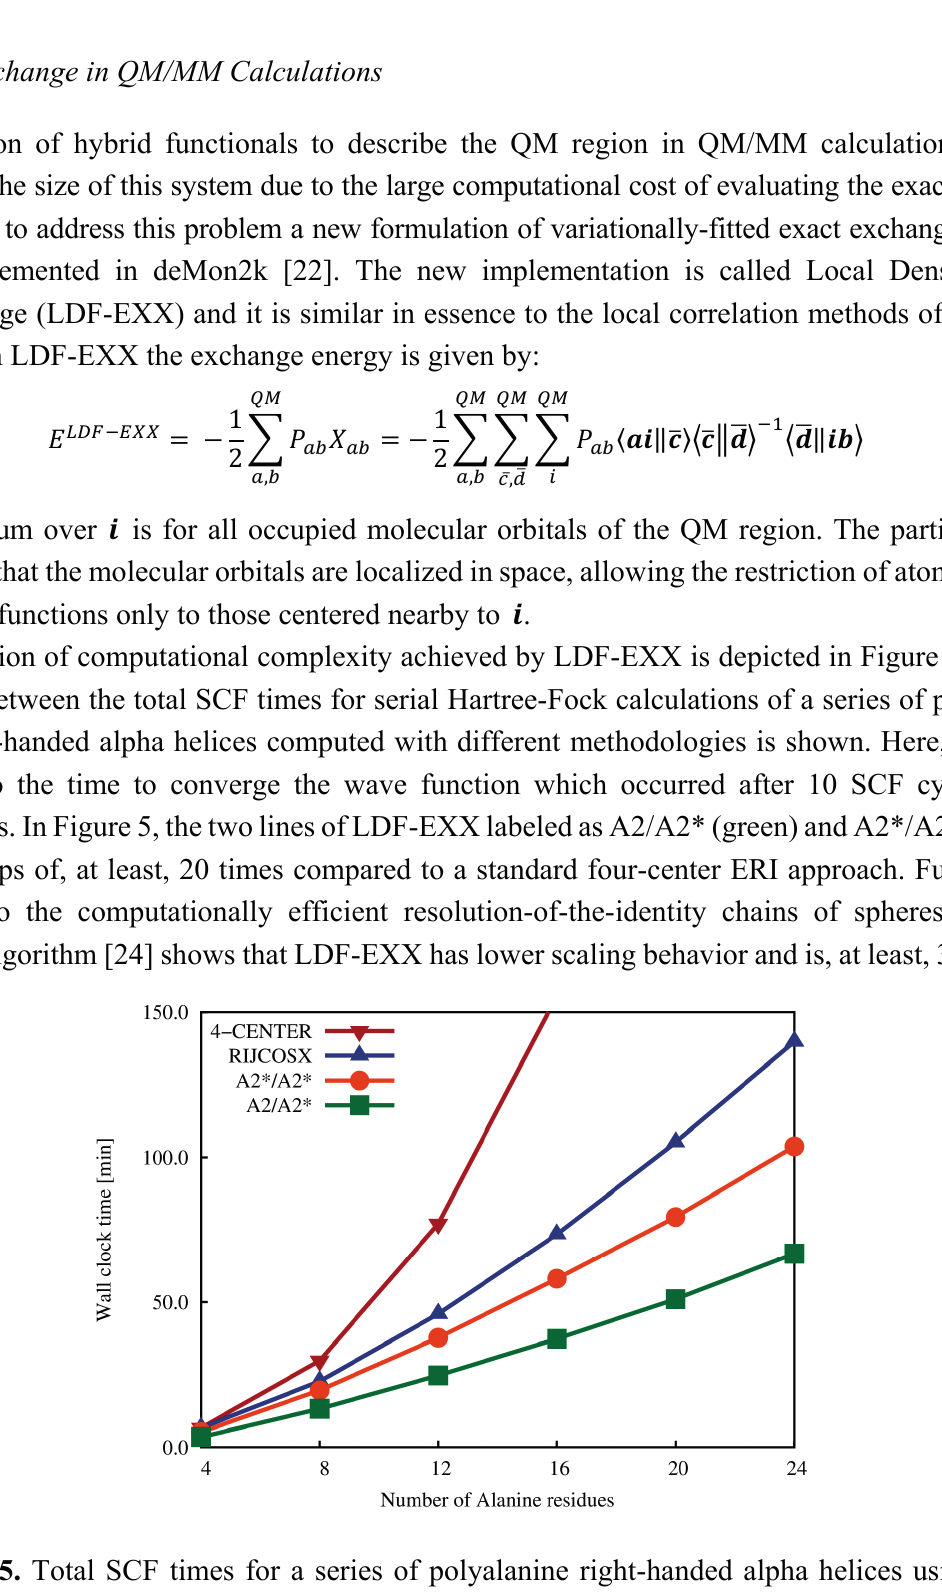
Figure 5. Total SCF times for a series of polyalanine right-handed alpha helices using a standard four-center ERI approach (red line), the resolution-of-the-identity with chains of spheres exchange method (blue line) and the LDF-EXX as implemented in deMon2k with different combinations of auxiliary function sets (orange and green